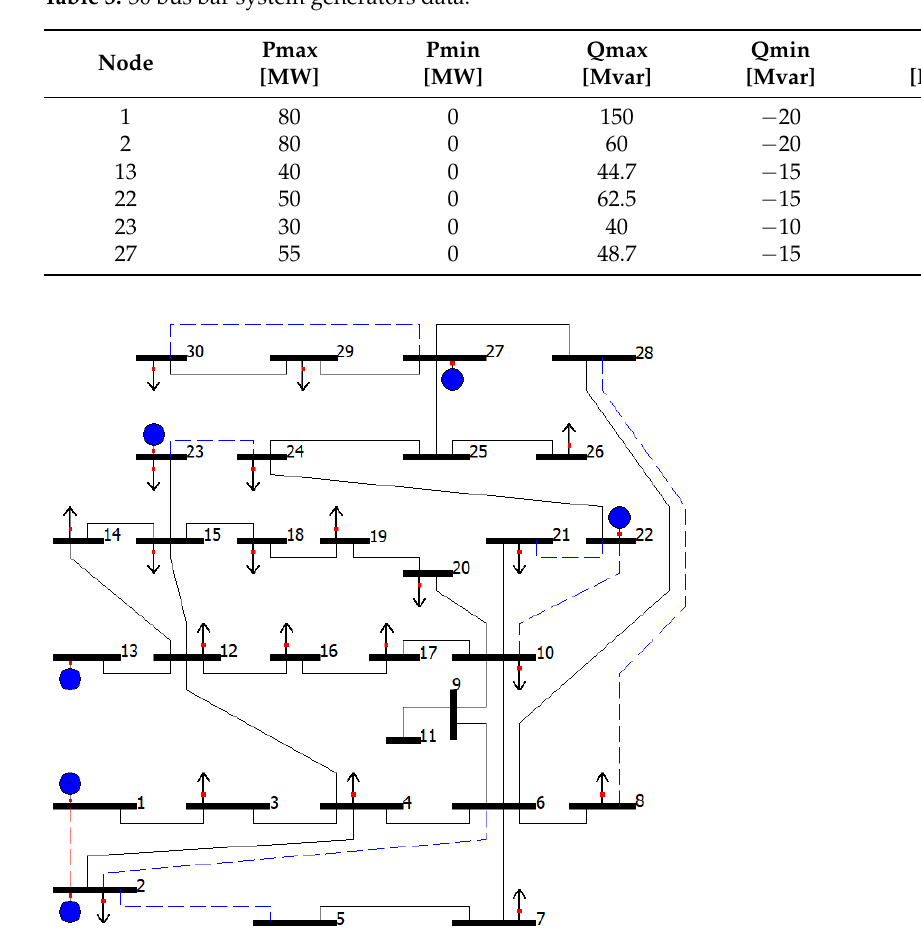
Table 3. 30 bus bar system generators data.